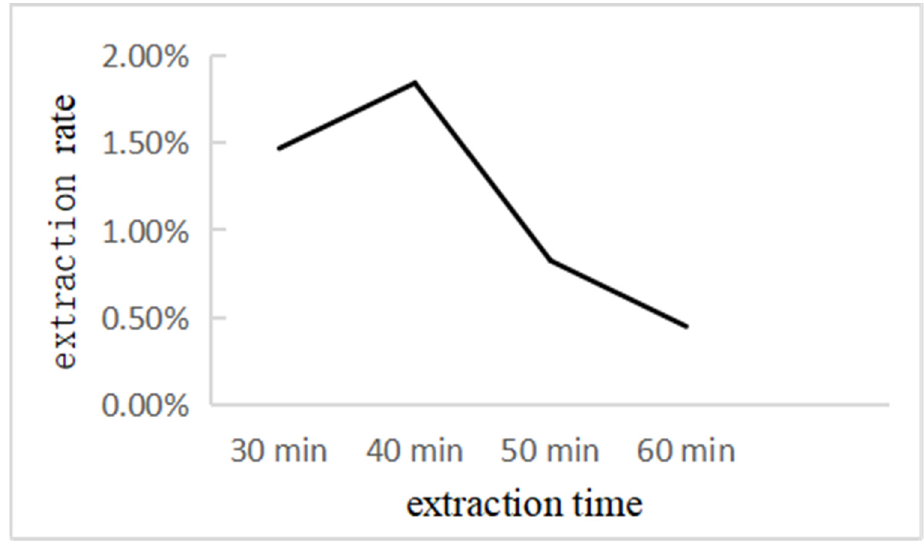
Figure 4. Effect of extraction time on the extraction yield of coumarins.